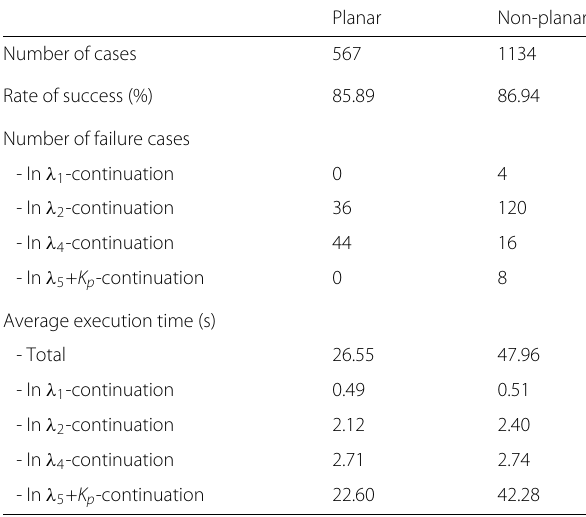
Table 4 Statistical results ( N = 2 and K = 1 × 10 3 ) Planar Non-planar